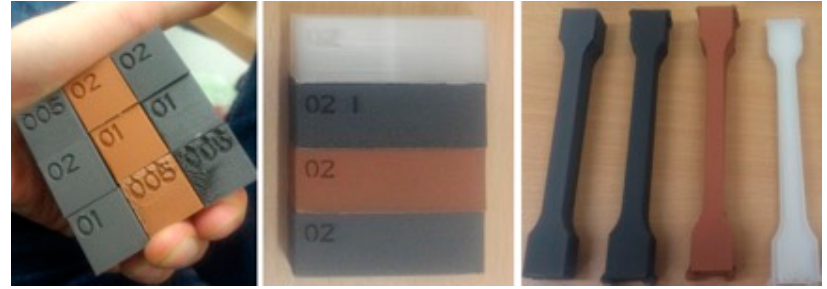
Figure 5. Samples for measuring surface